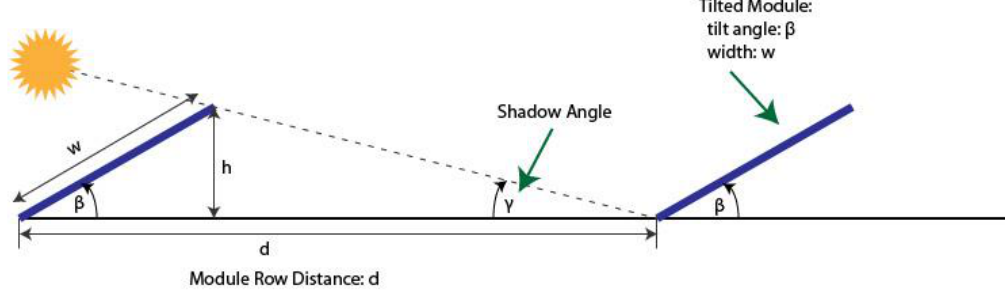
Figure 12. Illustration of PV module spacing [33].